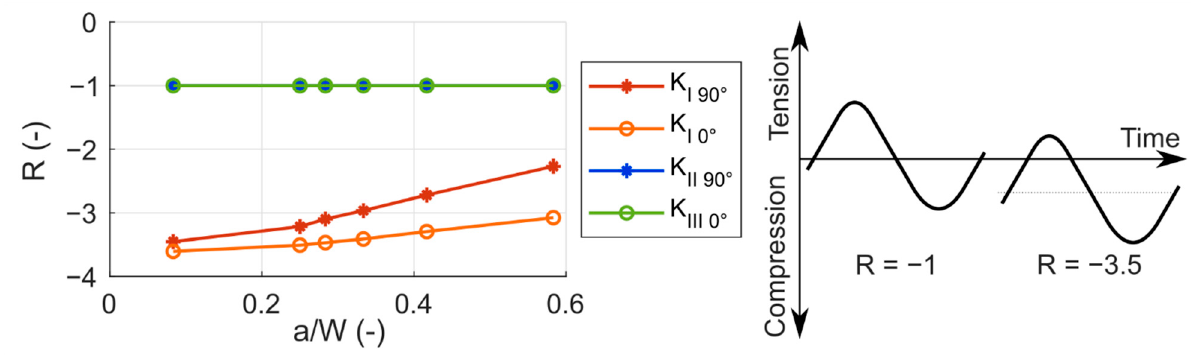
Figure 10. The R -ratio for different loading modes at different positions on the crack front during crack growth ( left ) with a schematic illustration of loading cycles with different R -ratios ( right ). The indices 0° and 90° indicate the position γ at the crack front.